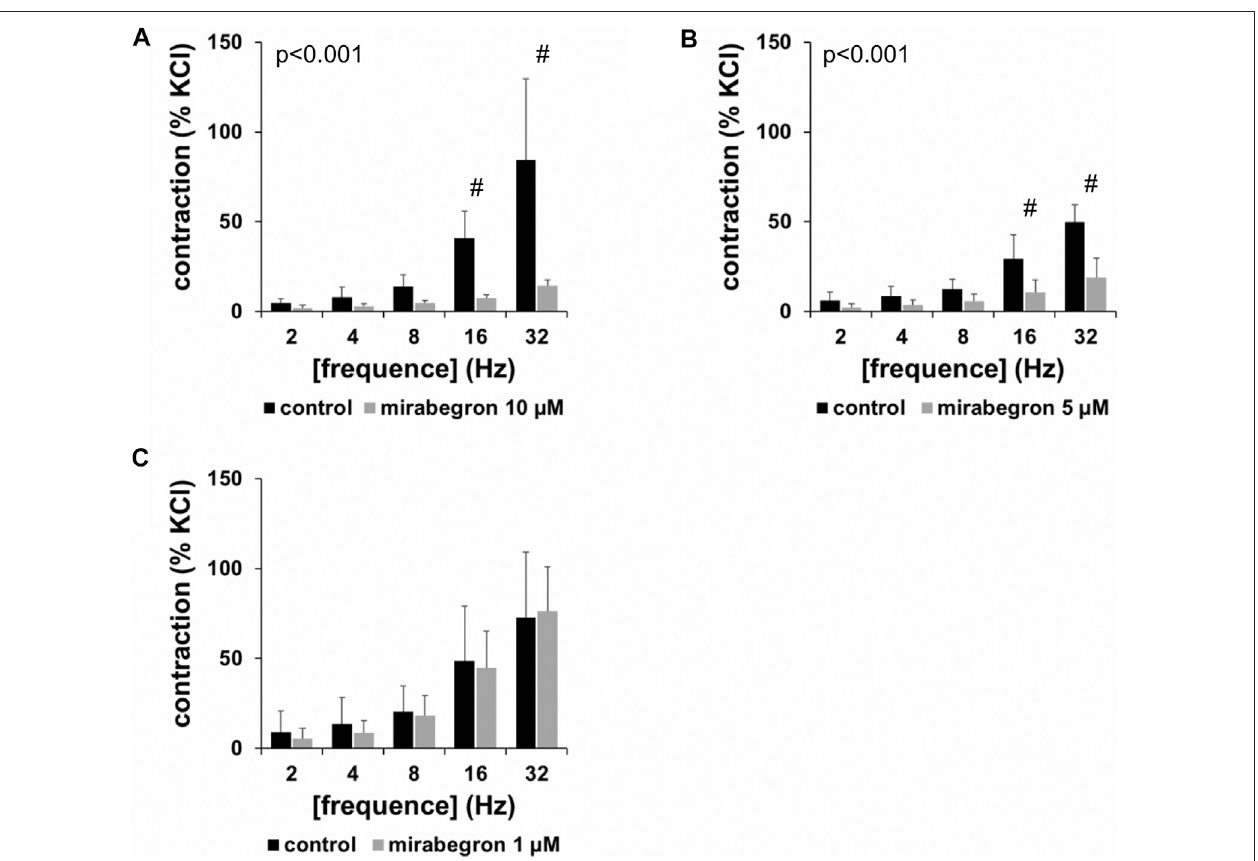
FIGURE 1 | Effects of mirabegron on EFS-induced contractions of human prostate tissues. Contractions of prostate tissues from the periurethral zone were inducedbyEFSinanorgan bath, 30 minafter addition ofmirabegroninconcentrationsof10 µM (A) ,5 µM (B) or 1 µM (C) ,oranequivalentamountofDMSO(controls), which was used as solvent for mirabegron. Shown are data from n (cid:1) 5 patients in each diagram, which are means ± SD in frequency response curves (# p < 0.05 for control vs. mirabegron by two-way ANOVA, and p values for whole groups in inserts from 1-way ANOVA).